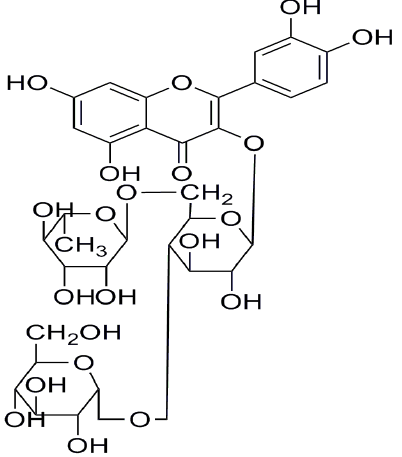
Figure 1. The chemical structure of glycosyl-rutin